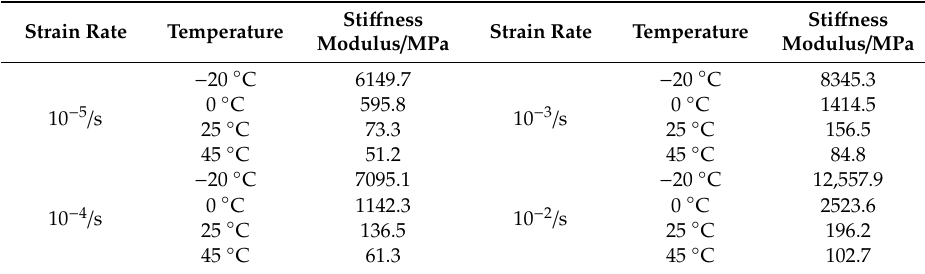
Table 3. Sti ff ness modulus of hydraulic asphalt concrete under various loading